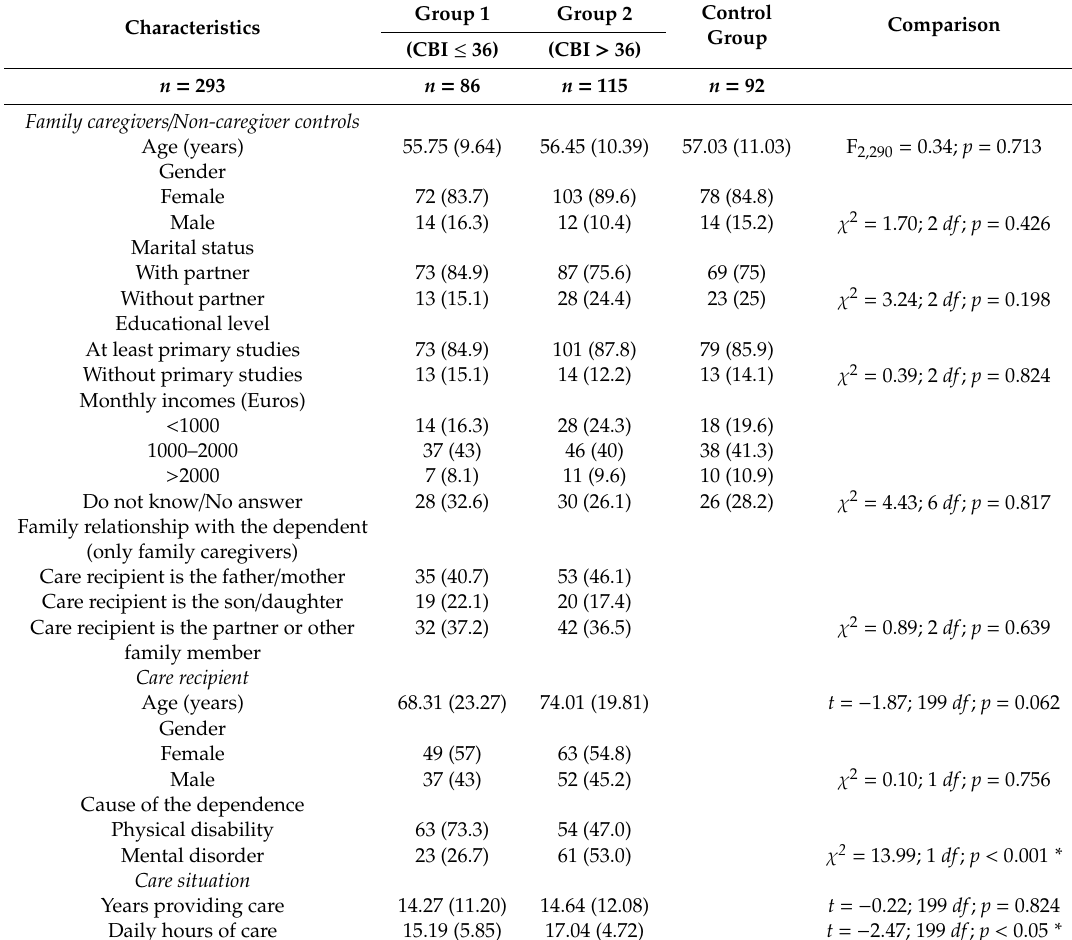
Table 1. Characteristics of the family caregivers and non-caregiver controls, of the care recipients and of the care